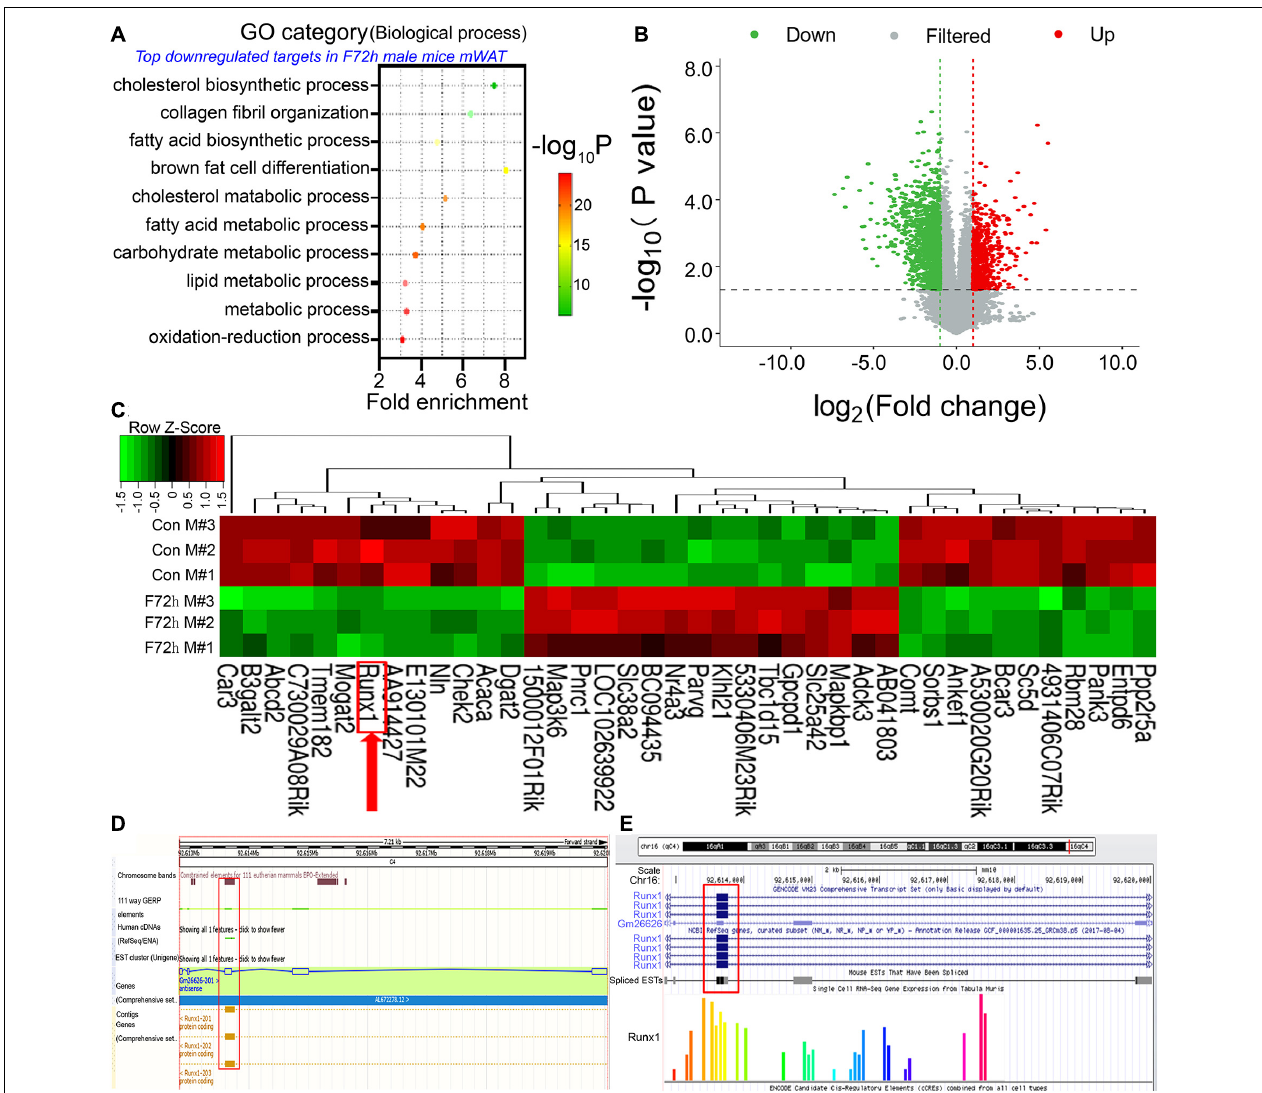
FIGURE 2 | Identification of differentially expressed mRNAs in the F72h mWAT compared to the control mWAT. (A) Gene ontology (GO) functional clustering of genes that were downregulated in F72h male mouse mWAT for biological processes (the top significantly affected categories are shown using the KEGG analysis tool). (B) A volcano plot illustrating differentially regulated gene expression from RNA-seq analysis between the control and F72h male mouse mWAT. Genes upregulated and downregulated are shown in red and green, respectively. Values are presented as the log2 of tag counts. (C) Cluster heat map showing differentially expressed genes in mWAT between the fasted mice and the control mice. The red arrow shows Runx1. N = 3. (D) UCSC database and (E) Ensembl database show that Lnc-FR332443 is the antisense lncRNA of Runx1 . Lnc-FR332443 is also found at Gm26626, and Gm26626-201 is located on chromosome 16: 92612824-92620032. There are five exons in this region, of which exon 3 overlaps with part of the transcripts of the Runx1 gene (red